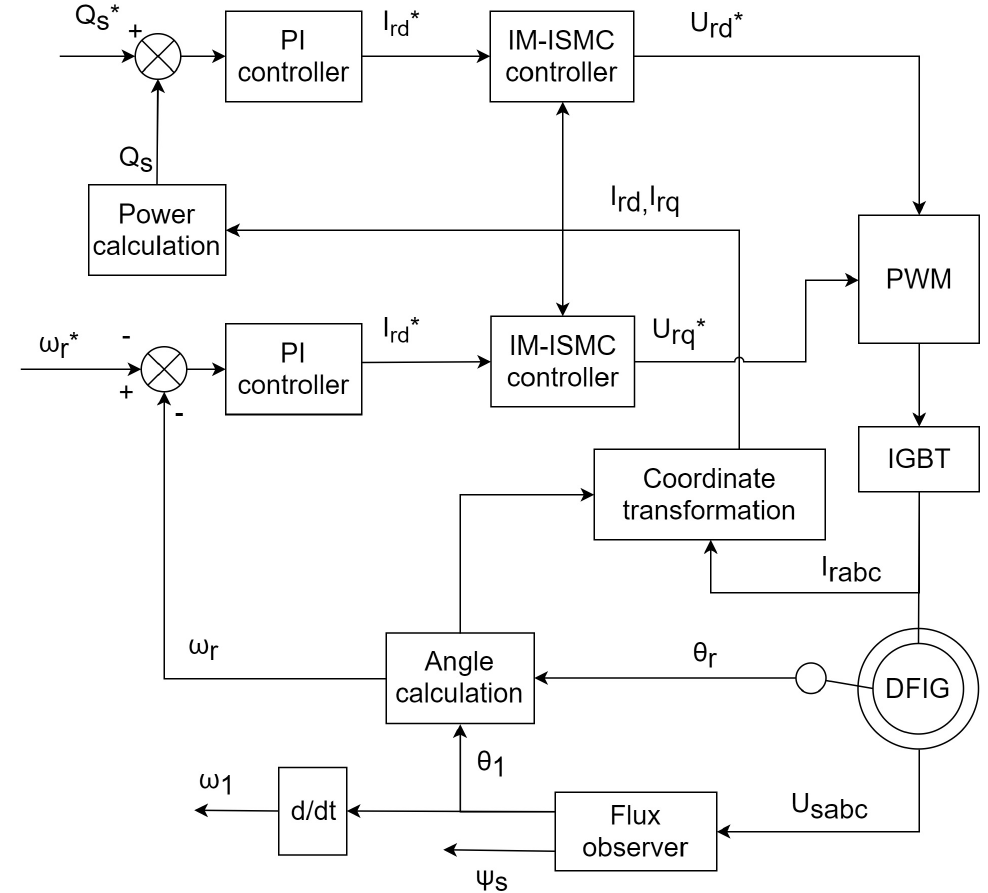
Figure 9. Description of floating offshore wind turbine system based on